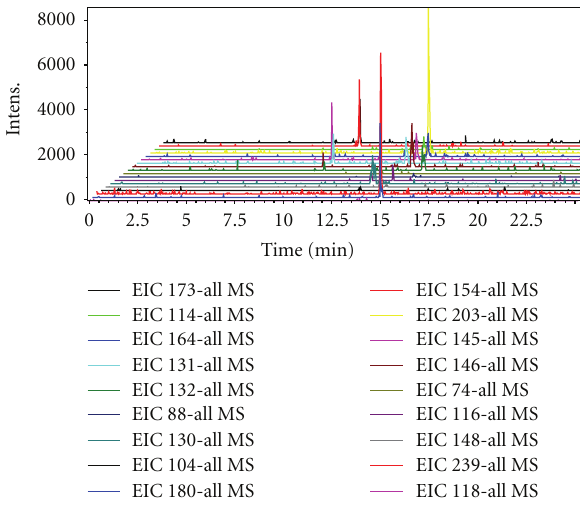
Figure 1: Total ion chromatogram of 18 kinds of amino acid standards.